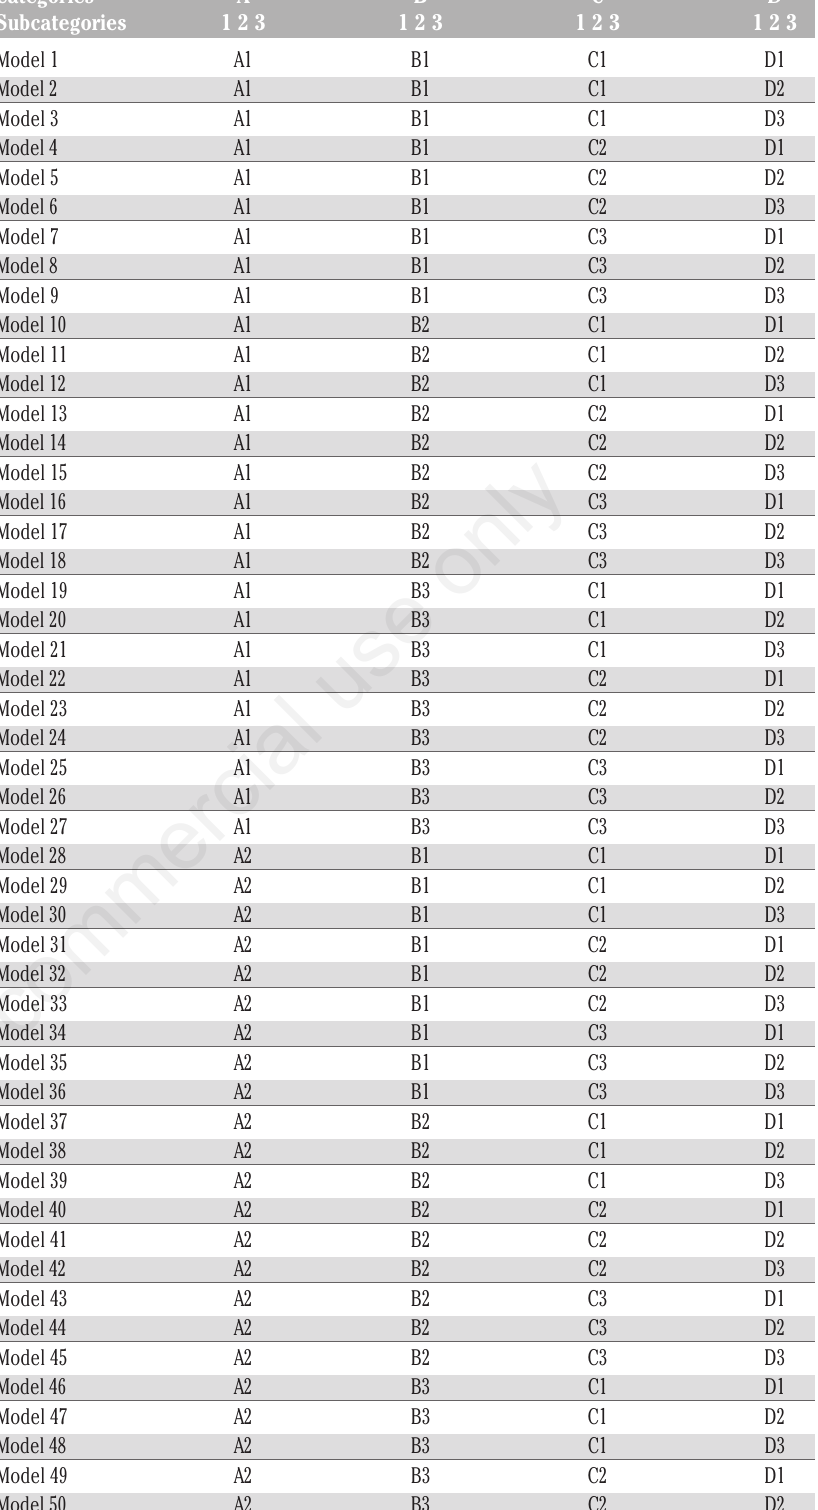
Table 5. Constructing the 81 models from the four categories A,B,C,D, where each cate- gory has three subcategories